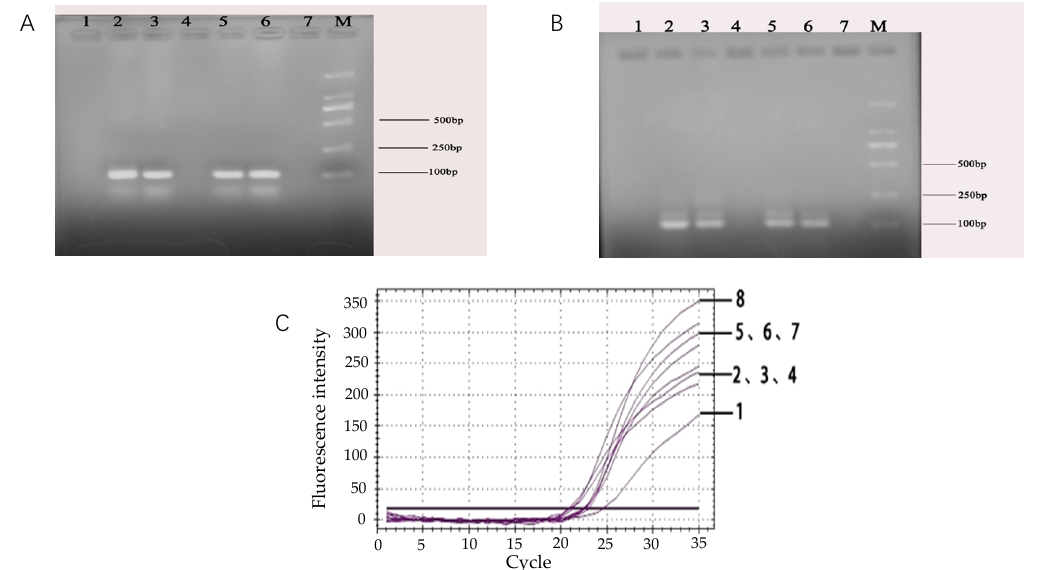
Figure 5. Products of the first step of PCR amplification. ( A ) Lane 2, 3, 5 and 6 showed the